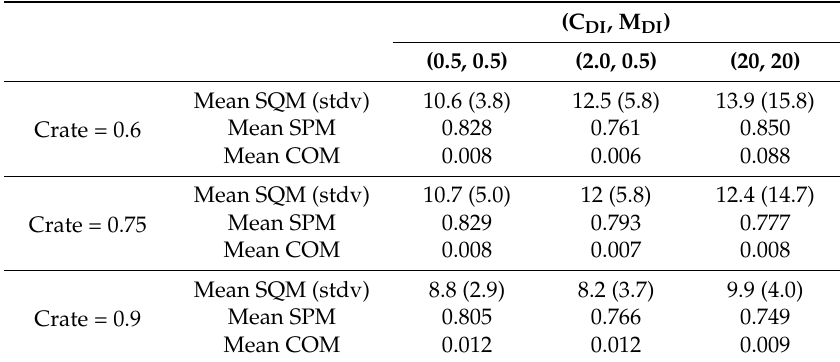
Table 6. Performance metrics of the nine cases of the crossover rate (Crate) and (crossover distribution index (C DI ) and mutation distribution index (M DI )) combinations. The total number of global Pareto solutions is